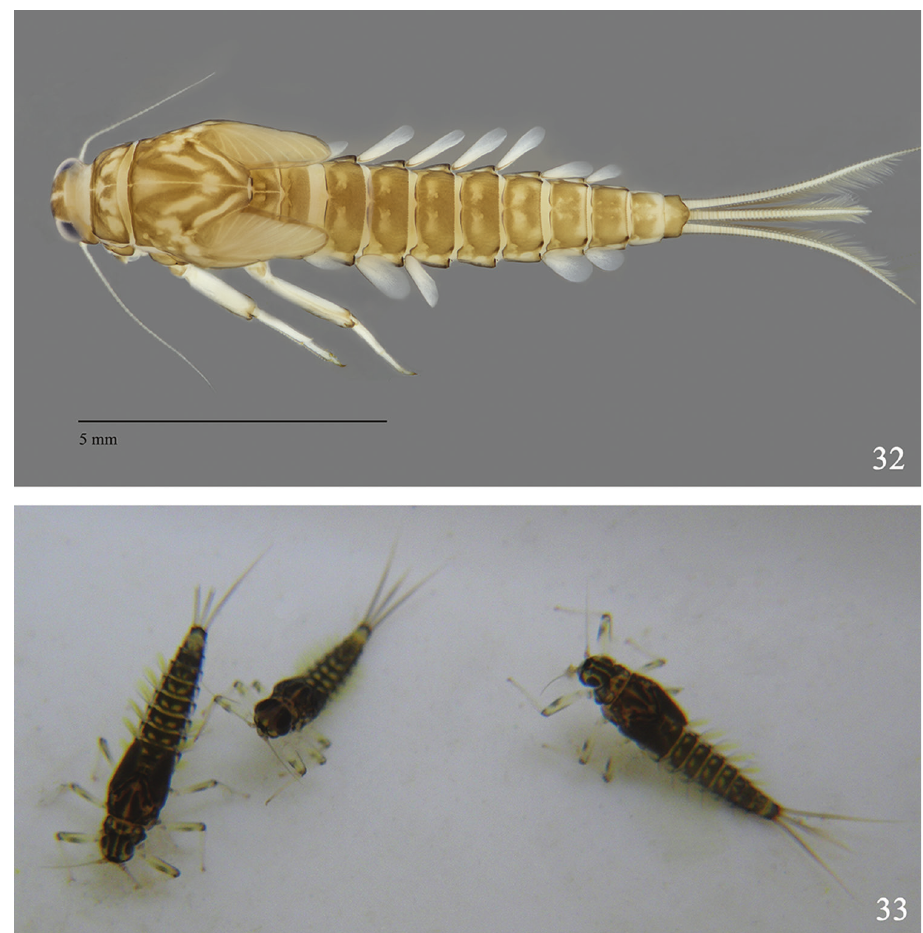
Figures 32–33. Larvae of Labiobaetis alahmadii sp. n.: 32 female larva (dorsal view) 33 larvae in vivo. Maxilla with a medioapical row of medium setae, basal end of row with a few long setae; posterior side of lacinia mediobasally with a row of four medium-sized setae, a single small seta close to the medial margin of lacinia; palp 2-segmented, as long as galea-lacinia, segment II with distomedial concavity (Fig. 23). Labium (Fig. 24) with glossae shorter than paraglossae; glossae with medium to long simple setae in apical half; paraglossae stout, apically rounded, with three rows of setae: two rows with simple setae and one row with setae feathered on one side; labial palp with segment I slender, quadrangular, as long as segments II and III combined; segment II with an elongated triangular distomedial projection with few scattered thin setae, on posterior side with a row of three medium setae; segment III subconical, with abundant scattered short thin setae and stouter